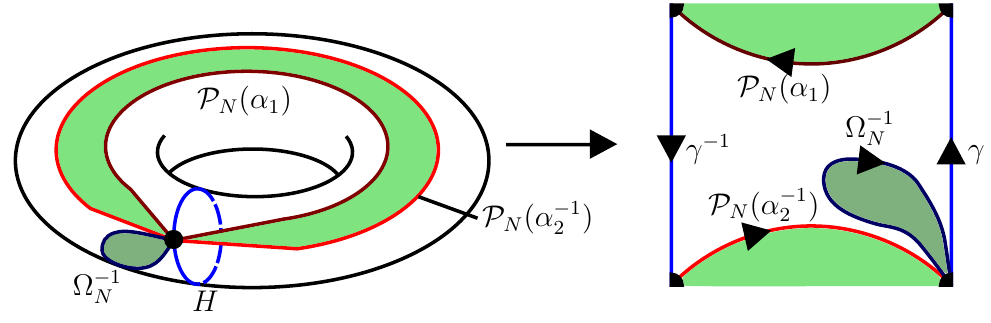
Figure 6 . TFT2 partition function for finite N BPS 2-point